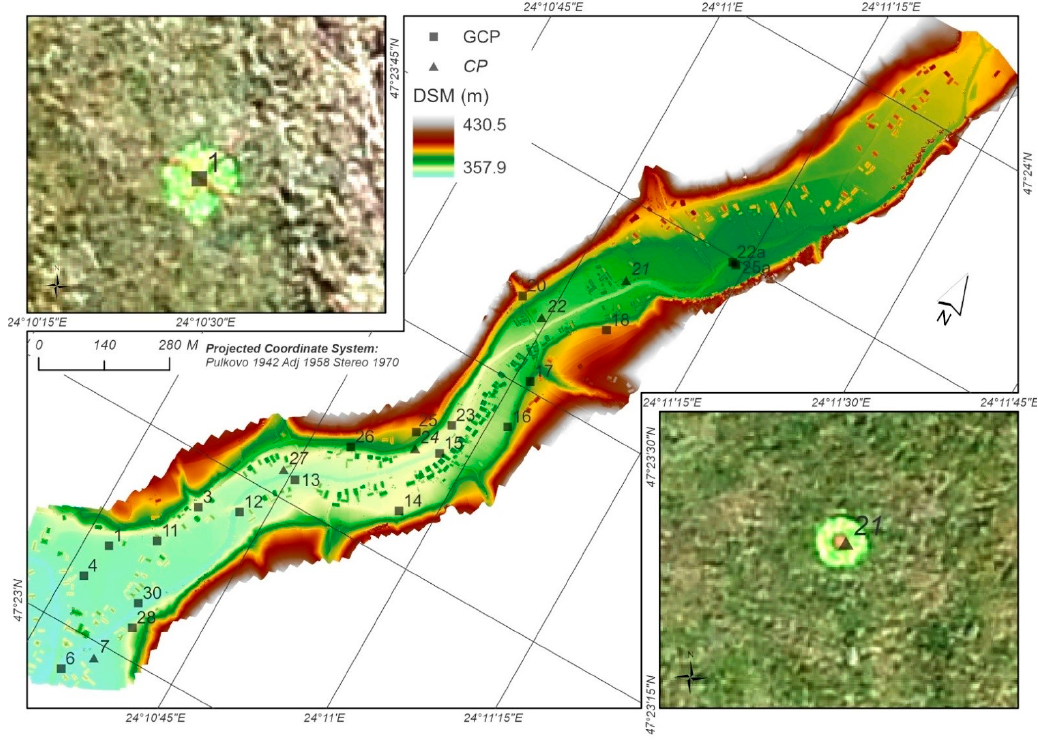
Figure 3. The geographical position of GCP and